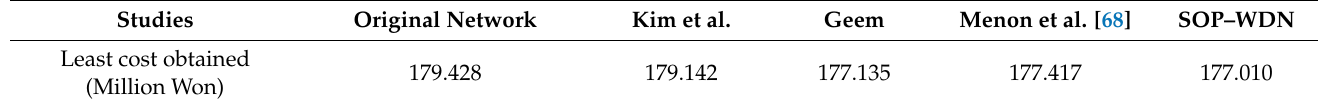
Figure 14. The GoYang network nodal pressure heads. Table 12. Comparison of the SOP–WDN results to those of past studies of the GoYang